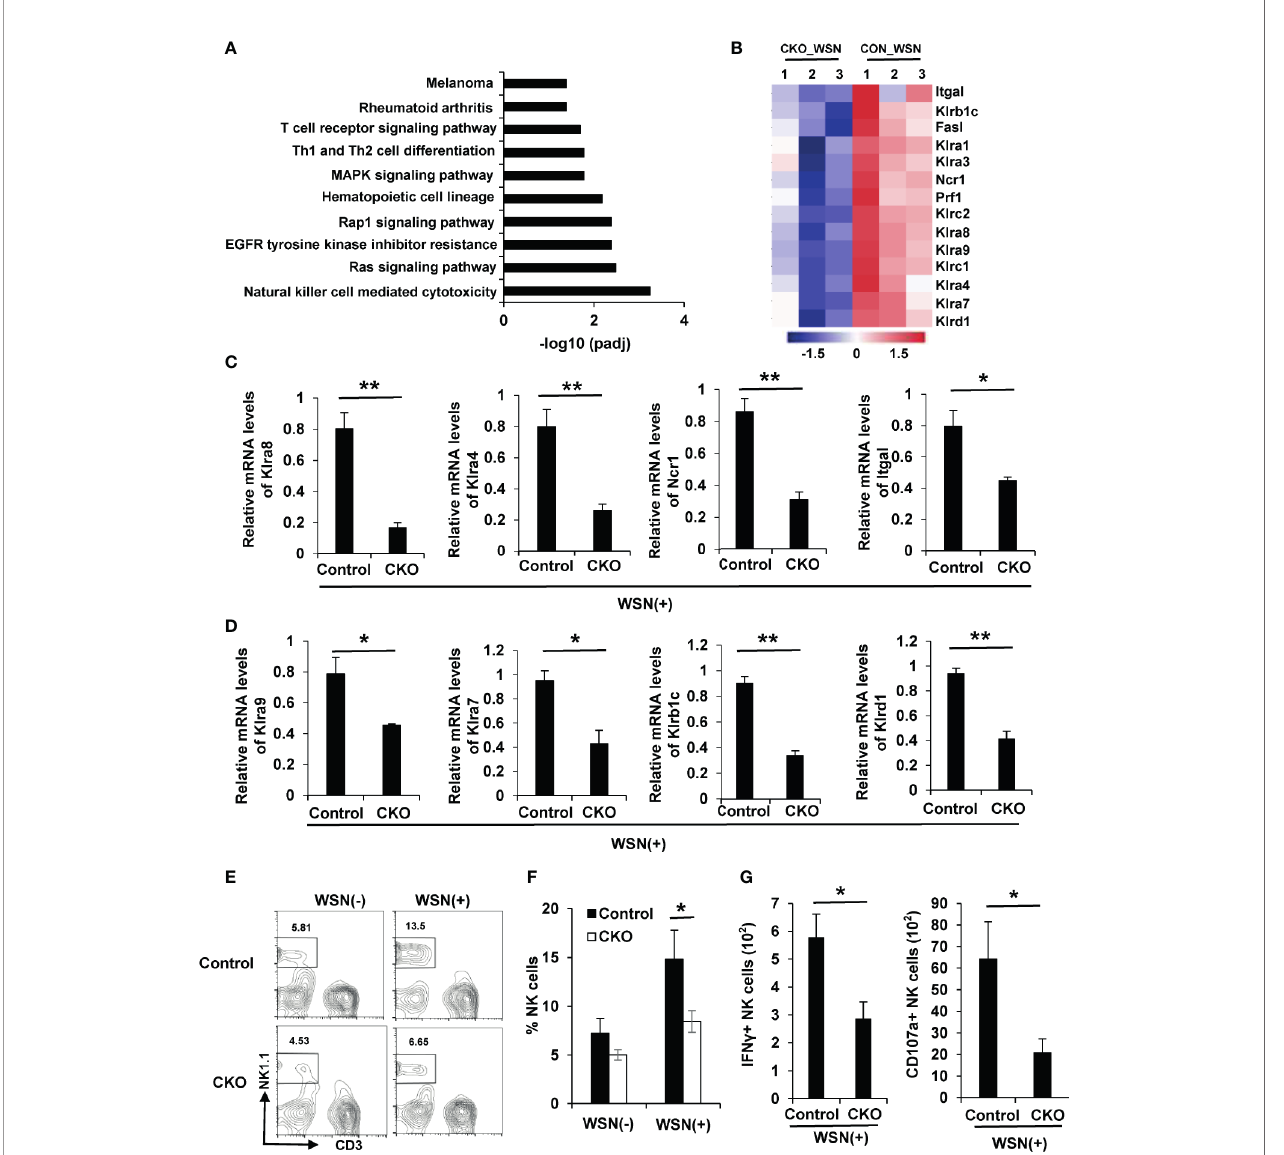
FIGURE 6 | De fi ciency of eIF4B impairs NK cell mediated cytotoxicity in mice. (A) Potential pathways for differentially expressed genes (DEGs) from transcriptome RNA sequencing, were examined by KEGG enrichment analysis. (B) Shown are the differentially expressed activating or inhibitory receptors of NK cells in WSN- infected lungs of eIF4B CKO mice as compared to control mice. (C, D) mRNA levels of activating (C) or inhibitory (D) receptors were detected by qRT-PCR. Shown are three independent experiments. (E, F) The percentage of NK cells in the lungs of uninfected or infected eIF4B CKO mice and control mice, was analyzed by fl ow cytometry. (G) The number of IFN- g + and CD107a+ NK cells in total NK cells. Data are represented as mean ± SD. **p ≤ 0.01 and *p ≤